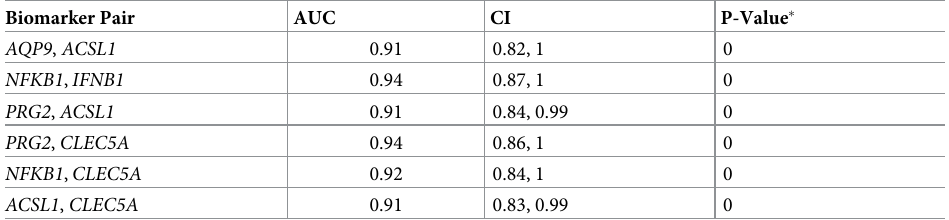
AUC, area under the curve; CI, confidence interval.